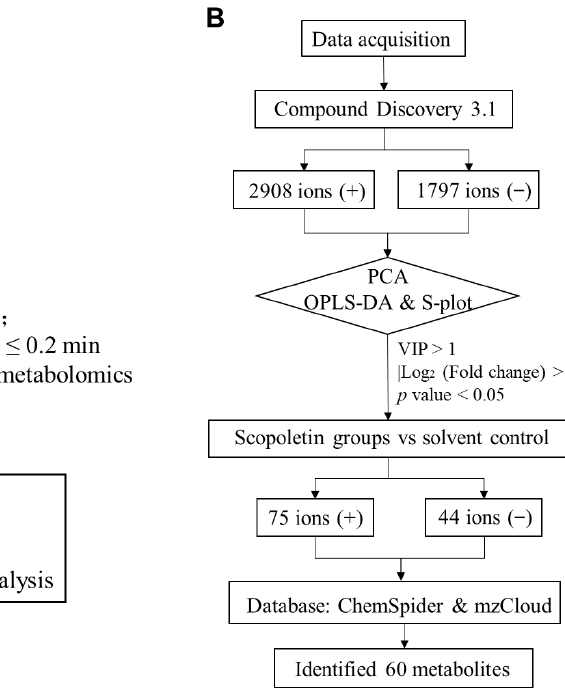
Figure 3. ( A ) The workflow of untargeted metabolomics approach in the current study. ( B ) Workflow of the identified differential metabolites in the untargeted analysis based on UHPLC-Q-Orbitrap-HRMS.